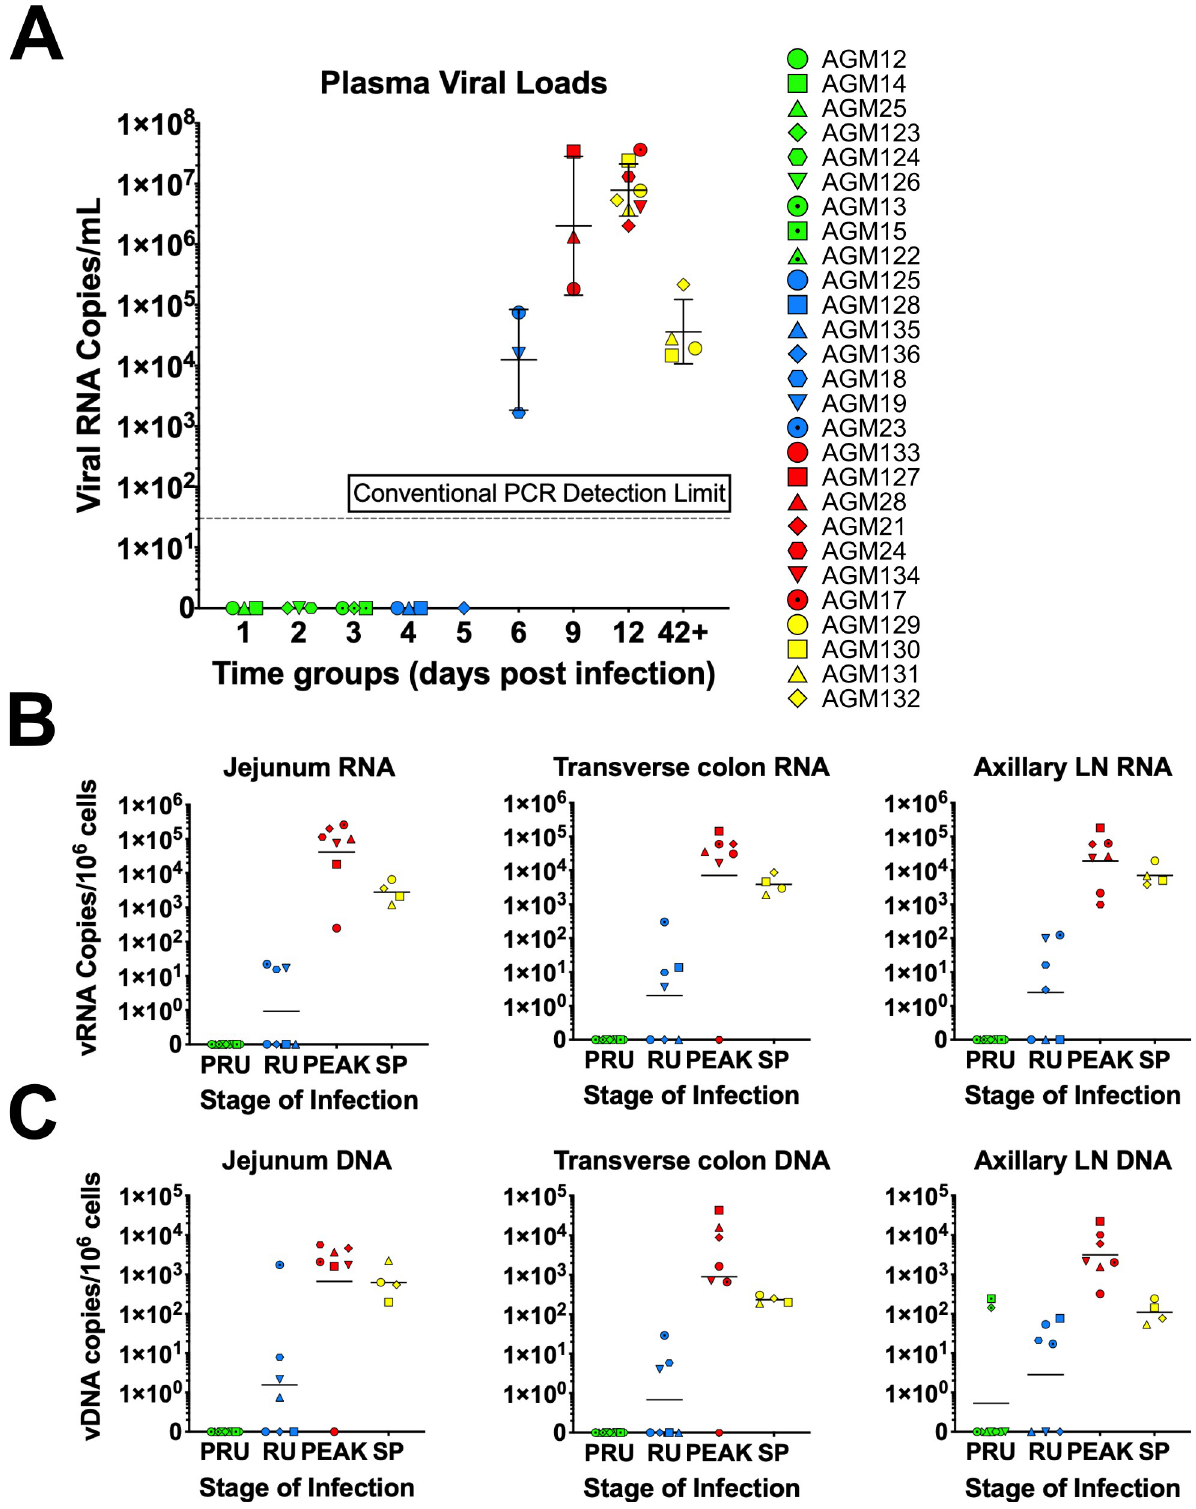
Fig 1. Blood, jejunum and transverse colon tissue viral loads in SIVsab90218-infected AGMs. AGM plasma viral loads (A) and the total number of copies of viral RNA (B) and viral DNA (C) per 10 6 cells are shown for three tissues: jejunum, transverse colon, and axillary LN. Each individual animal is represented by symbol with a unique color and shape combination, as shown in the legend to the right of (A). The four groups are based on the days postinfection, with: PRU (preramp, 1–3 dpi), RU (ramp-up, 4–6 dpi), PEAK (peak, 9-12dpi) and SP (set-point, 46–55 dpi). Each group is